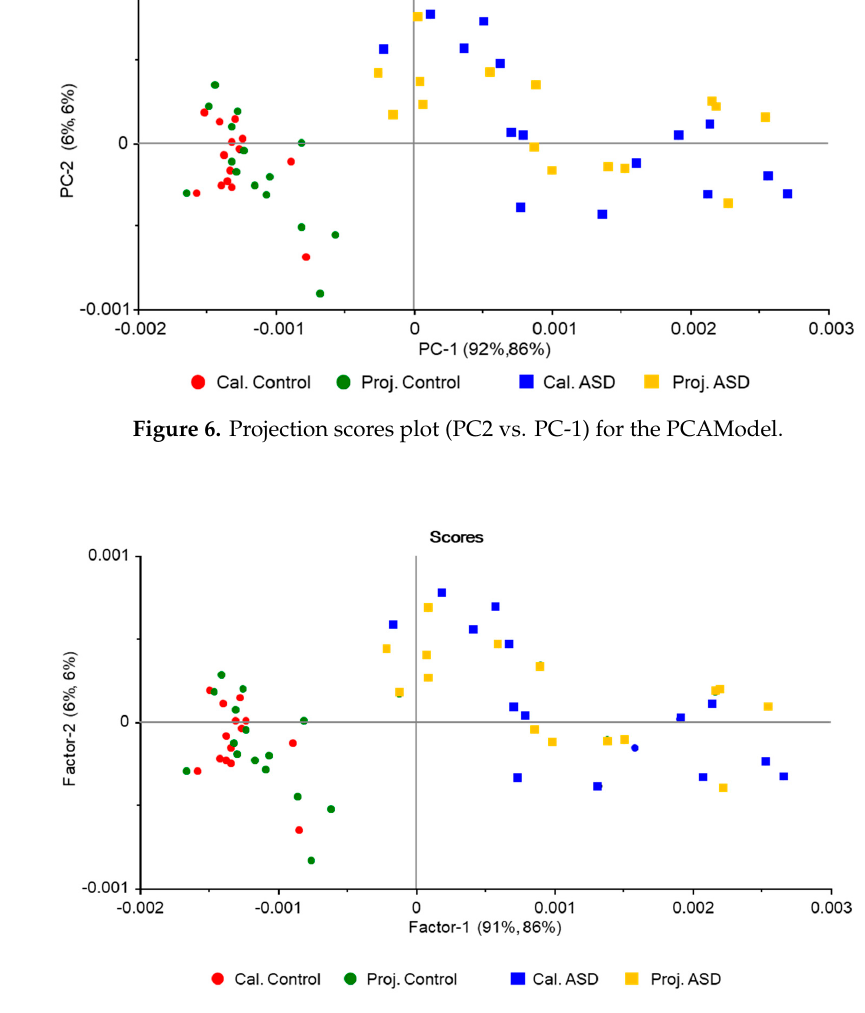
Figure 8. PLSModel predicted Y values for ASD (A group) and control (C group) test samples. The predicted values are indicated by the horizontal red lines, and the deviations by the blue boxes. In the model, samples belonging to control group define class 1 (value 0 for Y ) and samples belonging to ASD patients define class 2 (value 1 for Y ). The fact that the two models show a similar prediction performance is striking. In fact, the performance of the PCA-based model is so good that the model derived using the supervised PLS- DA method, which could a priori be expected to outperform the unsupervised PCA-based model, does not improve on this latter in a noticeable way. Under these circumstances, the simplest PCAModel appears to be the most convenient model for practical use.